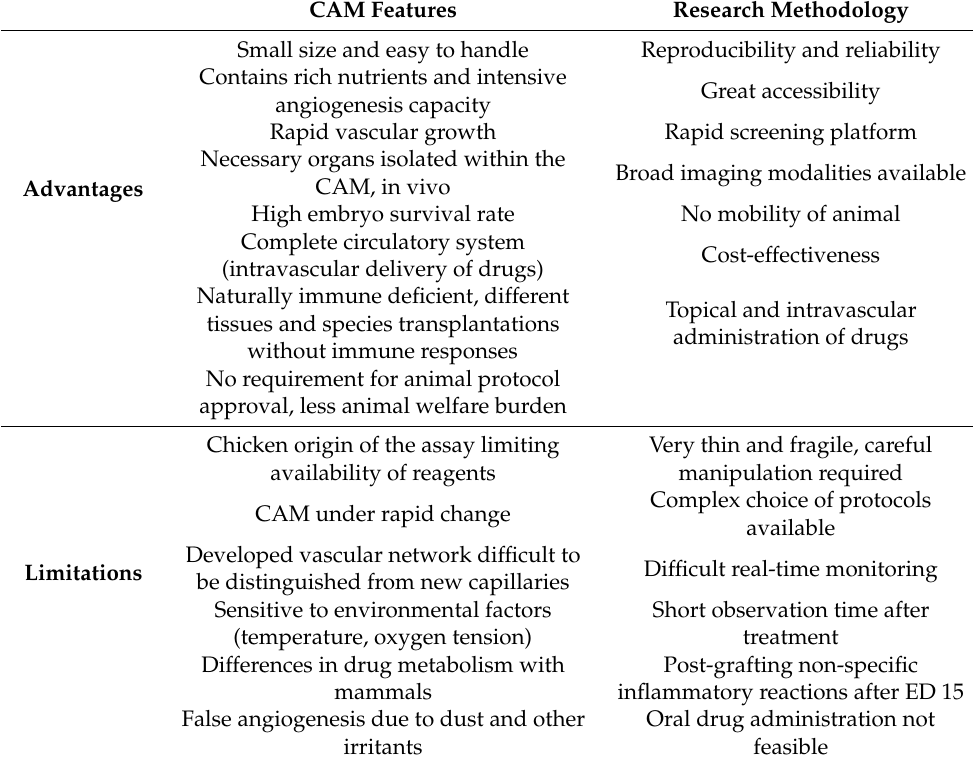
Table 8. Advantages and limitations of the CAM as a screening